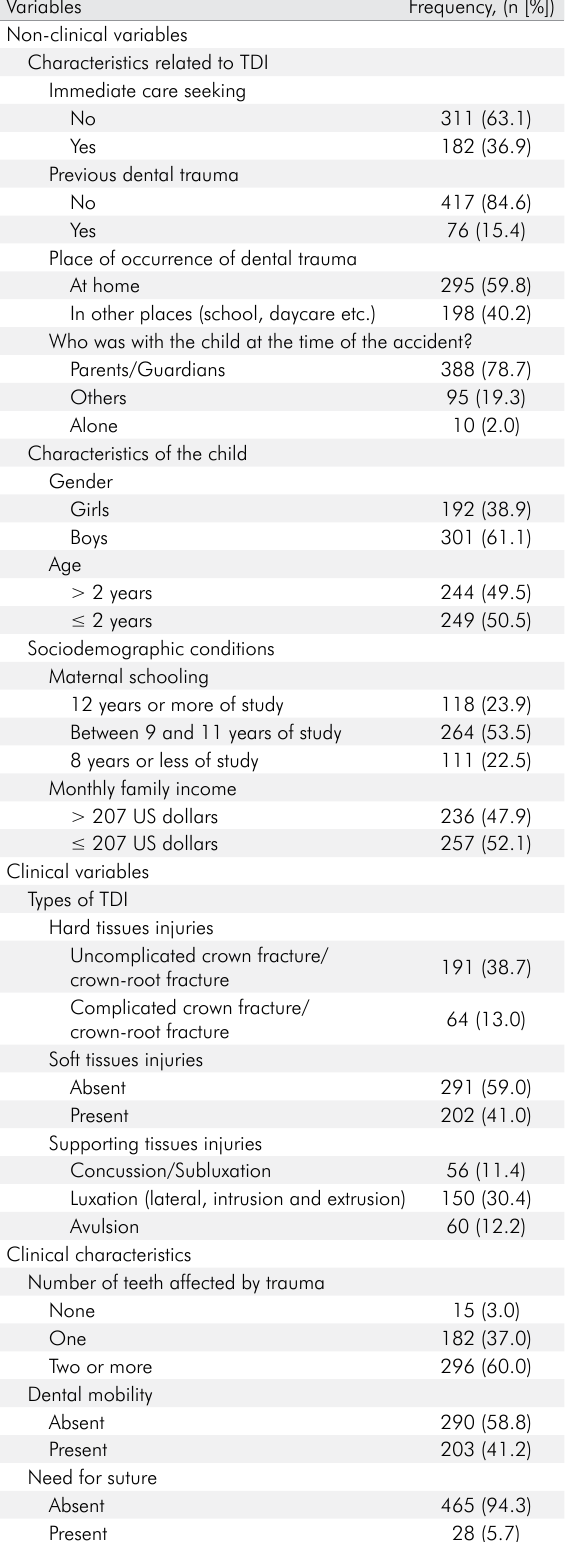
Table 1. Characteristics of the attended children (n = 493) according to study